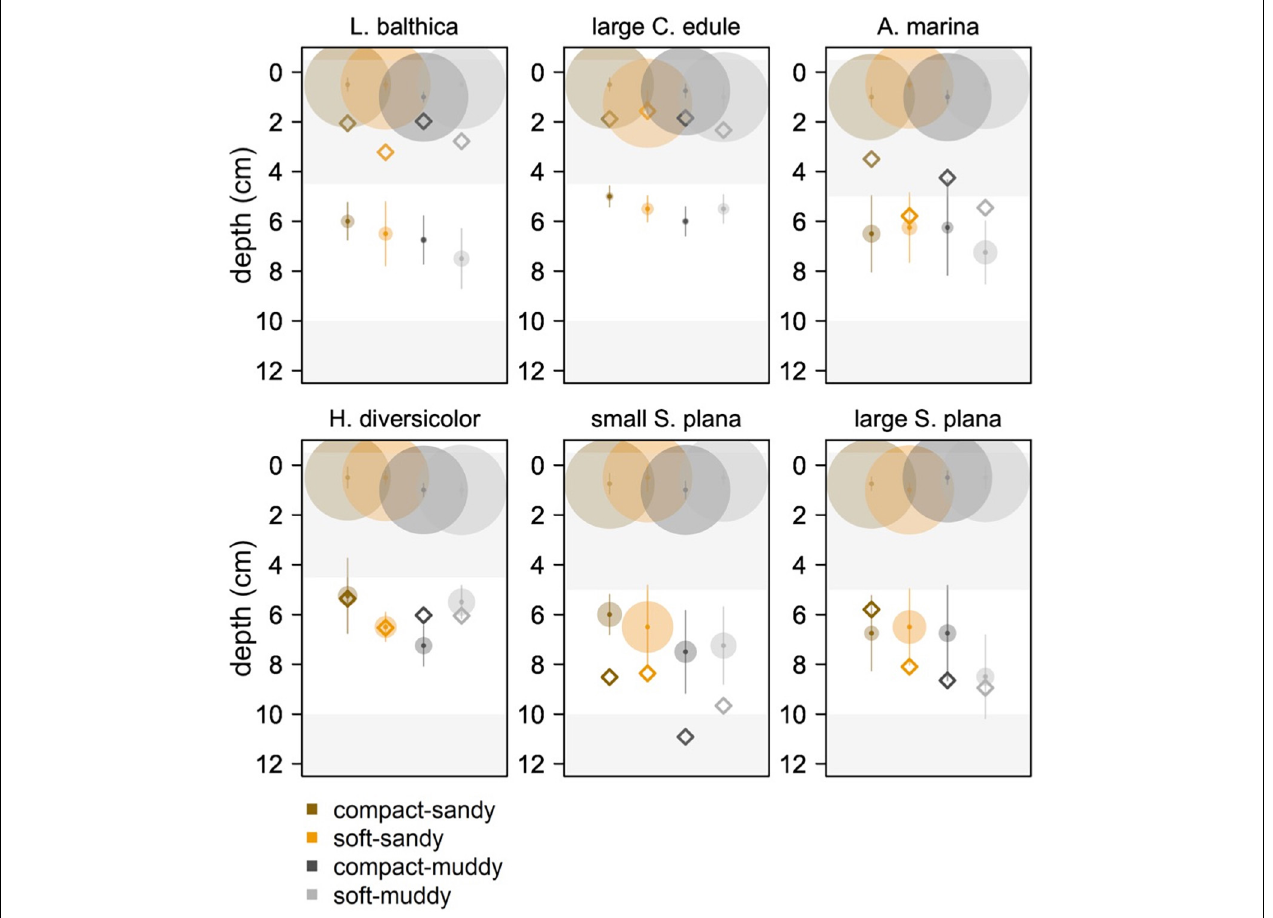
FIGURE 9 | Median locations (with standard deviation in vertical lines) of peak luminophore pixel counts (center of the circle circle) for the 0–4 cm diffusion layer interval and for the non-local mixing interval, represented by a white layer in the plot. We wanted to show peaks in luminophores in the top diffusion layer and at depth. The white depth interval excludes the diffusion layer (0–4.5 cm for L. balthica , C. edule , and H. diversicolor , 0–5 cm for S. plana and A. marina ) and the bottom of the core (10–12 cm) where excess luminophores pooled. The limit of the diffusion layer was determined as the depth of first inflection point in the luminophore profile curves of the previous figure, rounded to the closest 0.5 cm. The 10 cm lower limit was a conservative estimate to exclude edge effects. The size of the circle is scaled to the median luminophore pixel count at the peak luminophore pixel location. The diamonds indicate the mean depth of the species/sediment